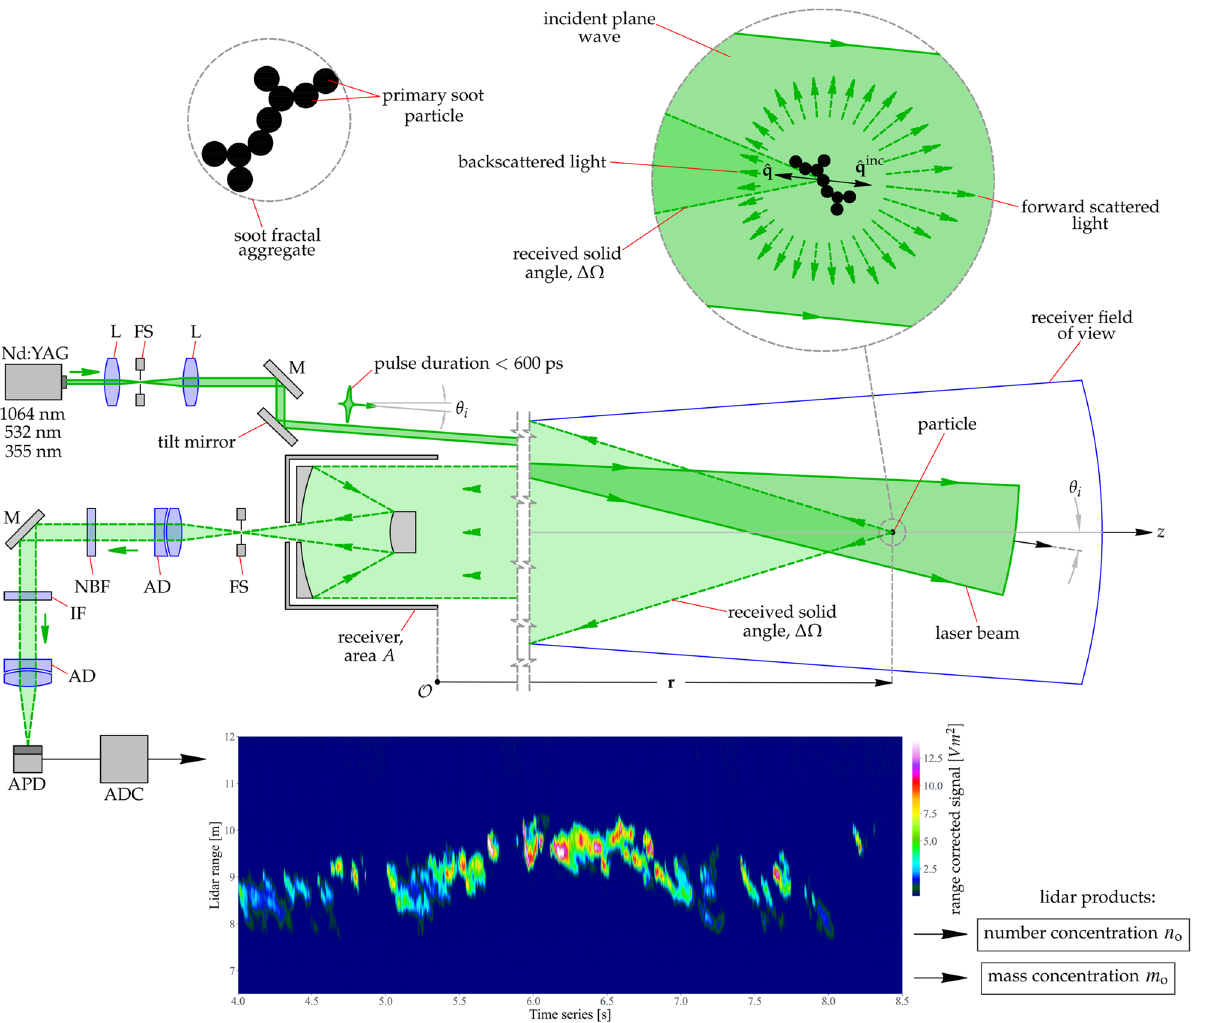
Figure 1. Principle of operation of the Picosecond Short-Range Elastic Backscatter Lidar (PSR-EBL) technique, intended to measure BC aerosol number and mass concentration, n o and m o , respectively. A picosecond laser pulse is emitted from the lidar transmitter to illuminate a column of BC aerosols in the direction ˆ q inc . When a pulse arrives at a particle (shown inset) at a range r , it may be partly absorbed and will scatter in all directions ˆ q . The lidar return signal is directly related to the light backscattered by the particle to the receiver’s area A , which defines the received solid angle (cid:31)(cid:30) . An example measurement of the return signal is shown at the bottom for a small-scale kerosene pool-fire at a range of 9 m from the instrument. Further description of the Colibri lidar is given in the Methods section.